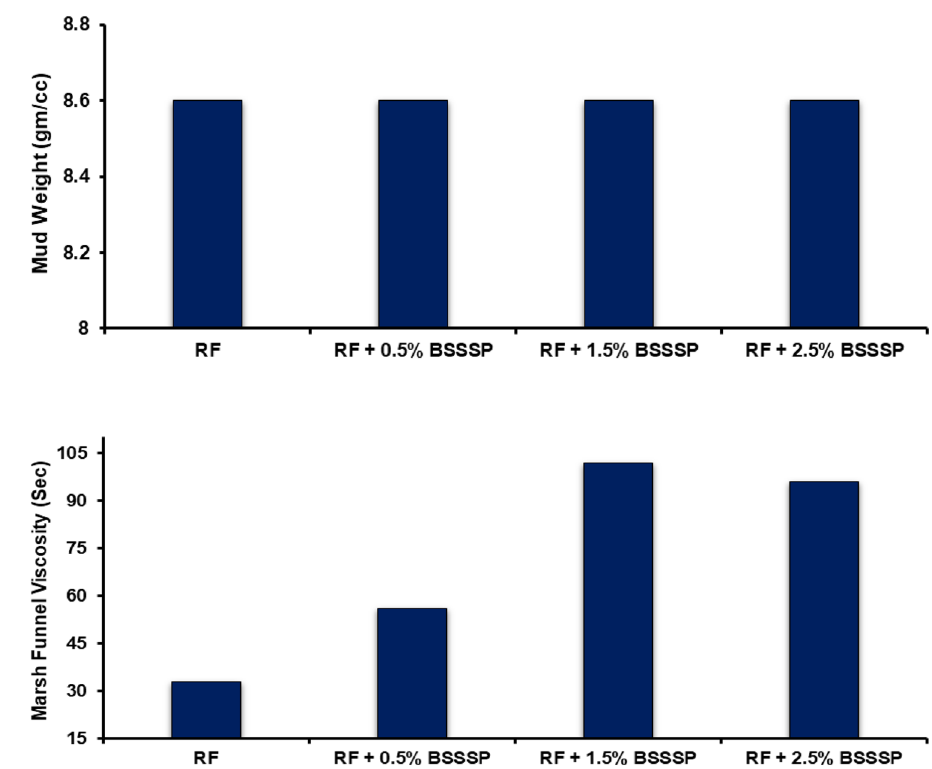
Fig. 12 The effects of BSSSP on the mud weight (fresh condi- tions)